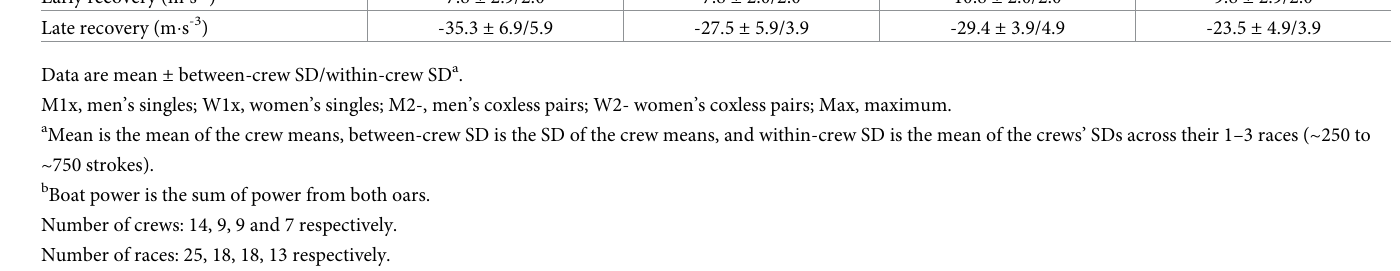
conducted to adjust for stroke rate, and to adjust for power output (P, the sum of both oars) and stroke rate. Fixed effects in these models were log(stroke rate) (adjusting log(V) for stroke rate), and log(P) and log(stroke rate) (adjusting log(V) for power output and stroke rate), and each predictor separately as linear predictors. In these analyses log(V) predicted by log(P) allows